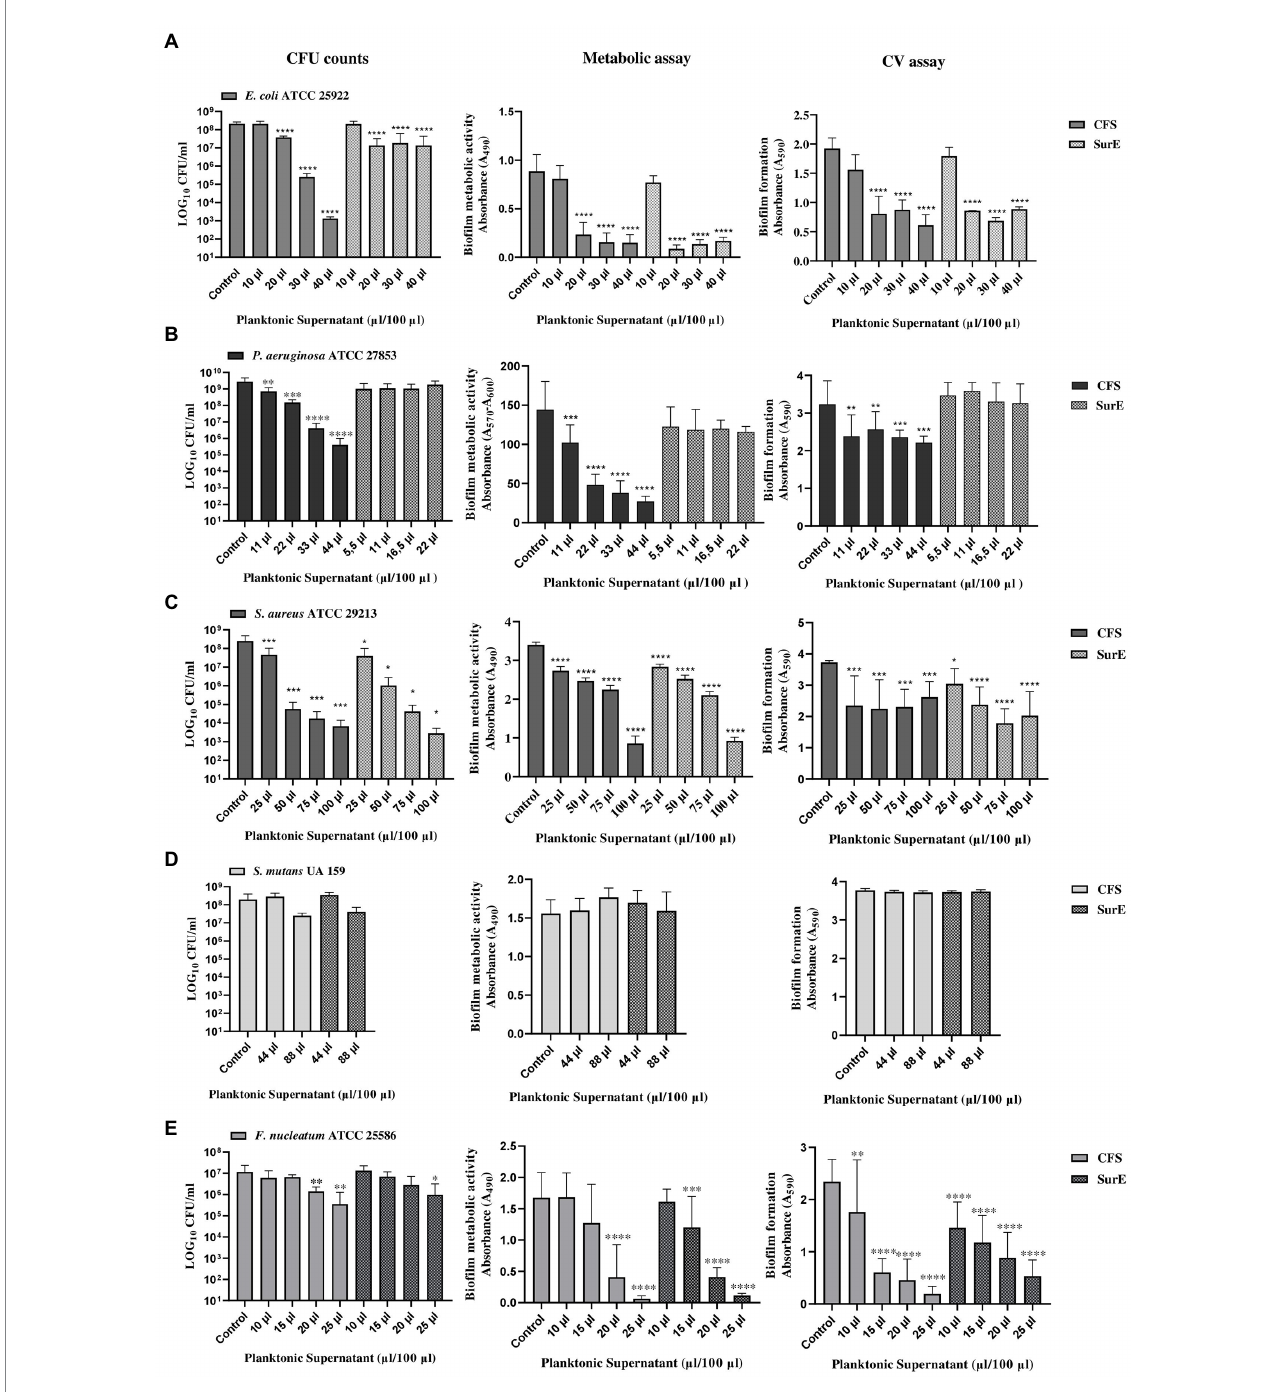
FIGURE 2 Determination of MBEC of CFS and SurE 10 K through CFU counts, metabolic assay, and CV assay vs. Escherichia coli ATCC 25922 (A) , Pseudomonas aeruginosa ATCC 27853 (metabolic assay) (B) , Staphylococcus aureus ATCC 29213 (C) , Streptococcus mutans UA 159 (D) , and Fusobacterium nucleatum ATCC25586 (E) . Data are presented as the mean of three replicates from two independent experiments. The statistical comparison between the control and treated samples was determined with a one-way ANOVA. The control was composed of media with the supplement of MRS broth. The error bars represent the standard deviation. The asterisks stand for p -value: * p < 0.05, ** p < 0.01, *** p < 0.001, and **** p <